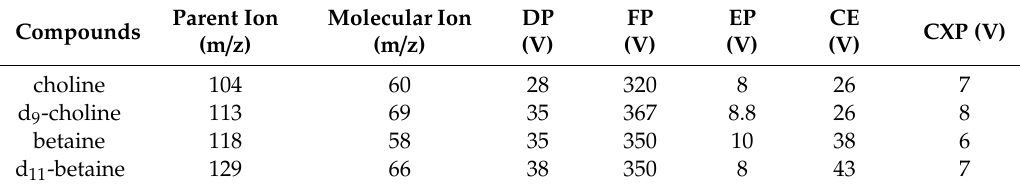
Table 1. Multiple reaction monitoring conditions of betaine and choline